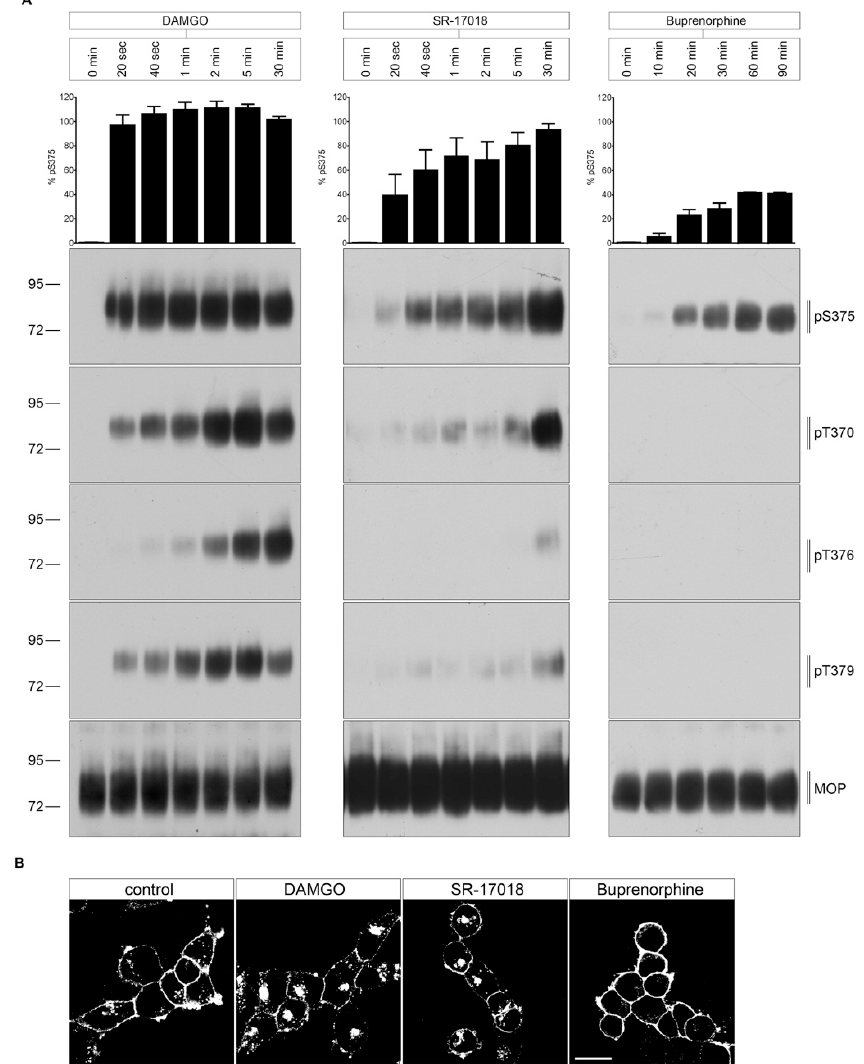
Figure 3. Time course of multisite phosphorylation by DAMGO, SR-17018, and buprenorphine. ( A ) HEK293 cells stably expressing HA-MOP were incubated with (left panel) 10 µ M DAMGO, (middle panel) 10 µ M SR-17018, or (right panel) buprenorphine for the indicated time periods at RT. Cells were lysed and immunoblotted with the anti-pT370 (pT370), anti-pT376 (pT376), anti-pT379 (pT379), or anti-pSer375 (pS375) antibodies. Blots were stripped and reprobed with the phosphorylation-independent anti-HA-tag antibody to confirm equal loading of the gels (MOP). S375 phosphorylation was quantified (upper panel) and expressed as percentage of maximal phosphorylation in control cells, which was set at 100% (data not shown). Data correspond to mean ± SEM from three independent experiments. Positions of molecular mass markers are indicated on the left (in kDa). Blots are representative of three independent experiments. ( B ) HEK293 HA-MOP cells were pre-incubated with anti-HA antibody for 2 h at 4 ◦ C. Afterwards, cells were treated with either 10 µ M DAMGO, 10 µ M SR-17018, or 10 µ M buprenorphine for 30 min at 37 ◦ C. After fixation, the cells were incubated with Alexa488-conjugated secondary antibody and examined using confocal microscopy. Figure shows representative images of three independent experiments. Scale bar: 20 µ